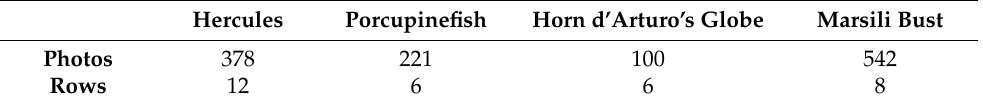
Table 5. Number of photos and revolutions with different optical axis inclinations around the